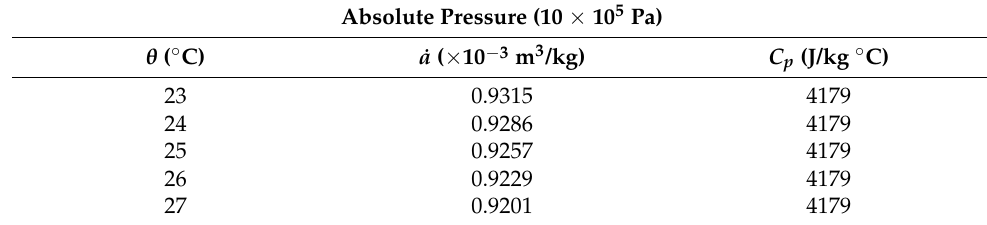
Table 4. Properties of water [2].